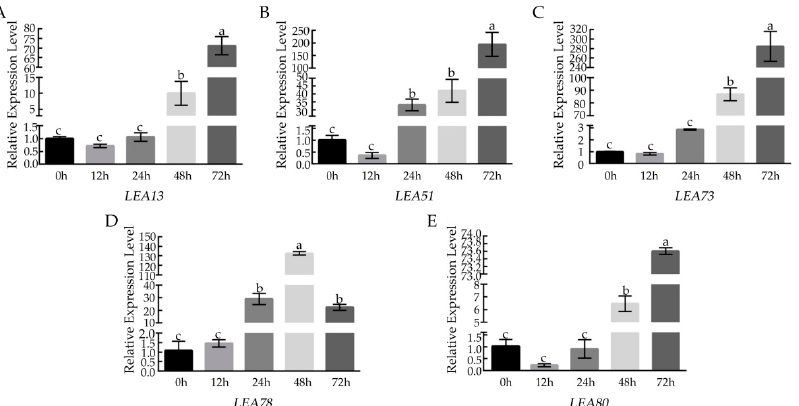
Figure 8. Relative expression level of BcLEAs under low ‐ temperature stress. ( A ) Relative expression of BcLEA13 level under low ‐ temperature treatment. ( B ) Relative expression level of BcLEA51 under low ‐ temperature treatment. ( C ) Relative expression level of BcLEA73 under low ‐ temperature treat ‐ ment. ( D ) Relative expression level of BcLEA78 under low ‐ temperature treatment. ( E ) Relative ex ‐ pression level of BcLEA80 under low ‐ temperature treatment. Bars with different letters “a, b, c, d” above the columns indicate significant differences ( p < 0.05, Duncan’s range test) on a given day of treatment. Relative gene expression levels were calculated using the 2 −ΔΔ CT method.